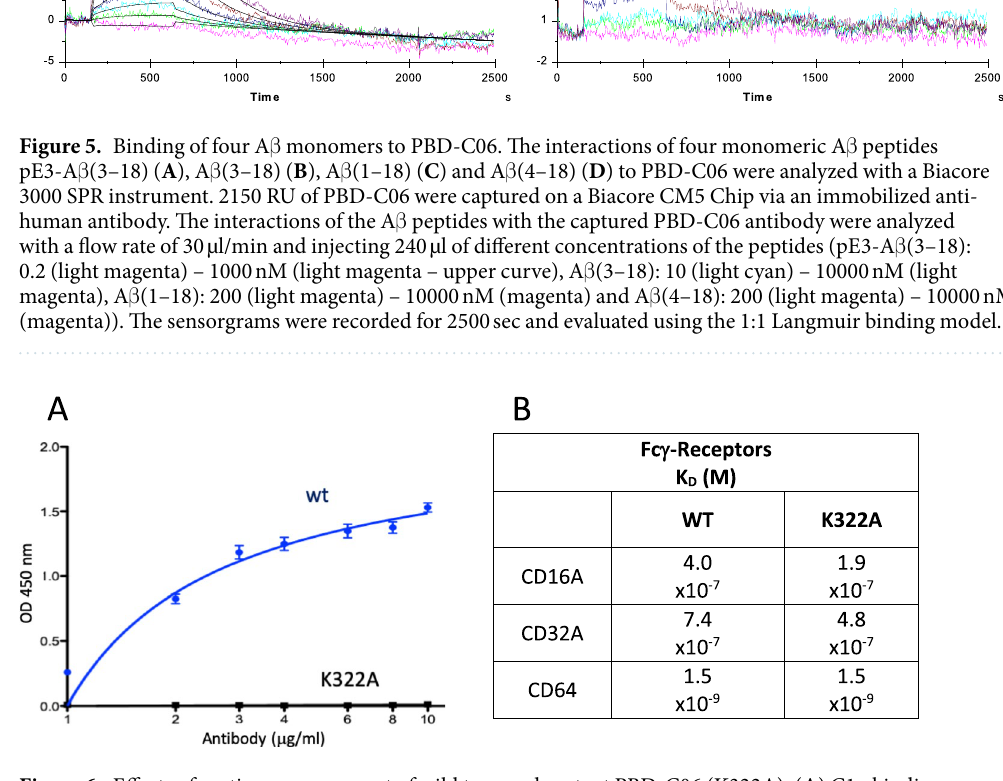
Figure 6. Effector function measurement of wild type and mutant PBD-C06 (K322A). ( A ) C1q binding was measured by ELISA. Plates were coated with 1 to 10 µ g/ml antibody and incubated with 2 µ g/ml C1q protein. For detection, a polyclonal anti-C1q antibody HRP-conjugate was used. ( B ) Fc γ -receptor binding assays were measured with a FortéBio BLItz system. Streptavidin sensors were loaded with 100 μ g/ml of biotinylated CD16a, CD32a and CD64a proteins, respectively. Association and dissociation rates were measured at five different concentrations (400 μ g/ml, 200 μ g/ml, 100 μ g/ml, 50 μ g/ml and 25 μ g/ml) of each